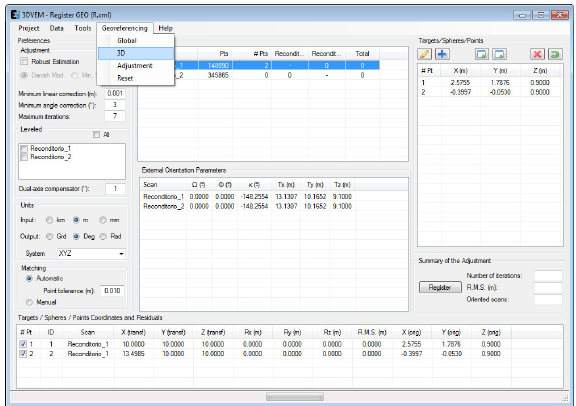
Figure 11. Exterior orientation parameters and transformed coordinates after carrying out the 3D transformation with 3DVEM – Register